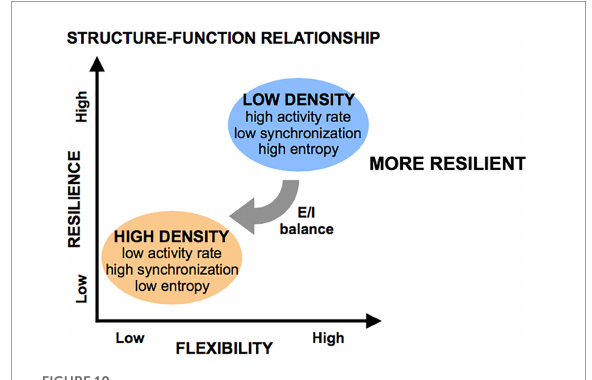
FIGURE10 Flexibility and resilience as a function of structural features. Low-density islands are inherently more flexible (defined as having higher entropy) than high density islands, a property which is mediated through the excitatory/inhibitory (E/I) balance (low in low-density islands, high in high-density islands). When subjected to injury, low-density islands are more resilient to low levels of injury than high-density islands. However, it is possible to significant degrade both circuit types if the microtrauma is